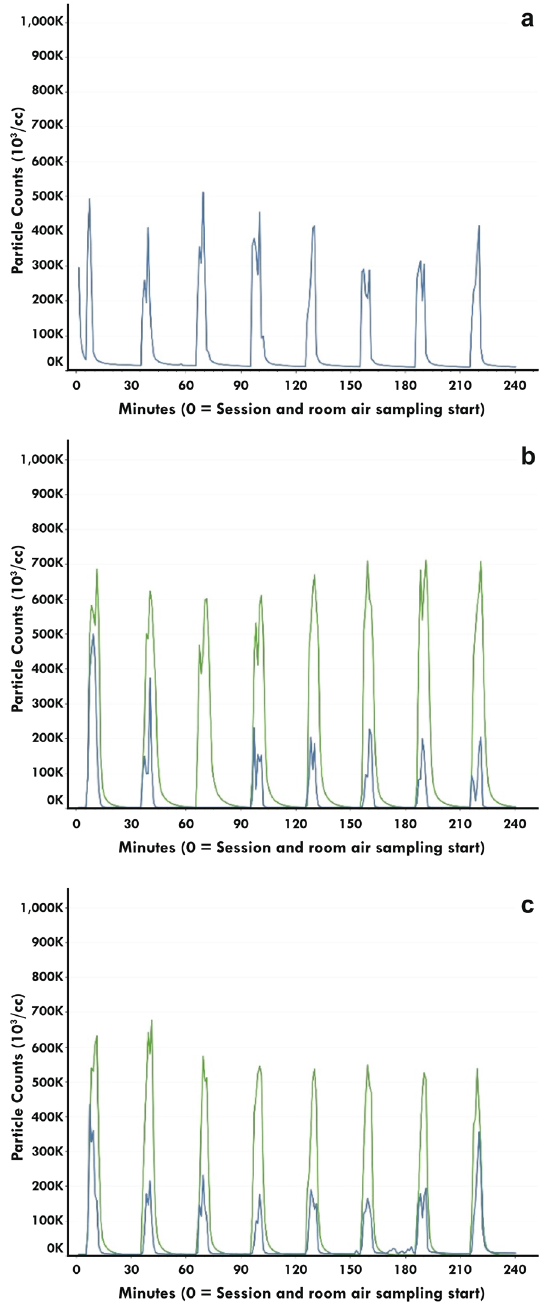
Figure 2. Comparison of the particle number concentration measured from prescribed product use in Groups I (blue line) and II (green line) in each ventilation condition (A = residential; B = Office; C = Hospitality). Note that for Group II in the residential ventilation condition there was no particle number concentration due incorrect device